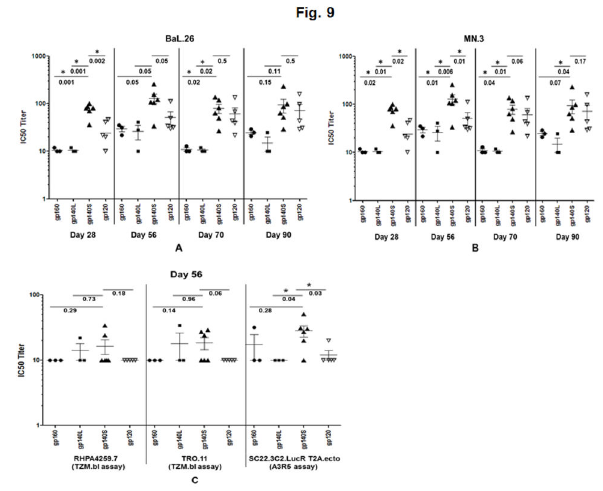
Figure 9. Virus neutralizing antibody activity (50%- inhibitory-concentration [IC ] titers) against homologous 50 HIV-1 clade B tier 1 strains (BaL.26 and MN.3) and heterologous clade B tier 2 strains (RHPA4257.7, TRO.11, and SC22.3C2.LucR. T2A.ecto) in sera from guinea pigs immunized with the indicated rNDVs. (A) Guinea pig sera obtained on days 28, 56, 70 and 90 were tested against BaL.26 pseudovirus by the TZM-bl assay (B) Guinea pig sera obtained on days 28, 56, 70 and 90 were tested against MN.3 pseudovirus by the TZM-bl assay (C) Guinea pig sera obtained on day 56 were tested against RHPA4257.7 and TRO.11 by the TZM-bl assay, and against SC22.3C2.LucR. T2A.ecto by the A3R5 assay. Horizontal bars indicate the geometric mean titer. Pre-immune sera were used to establish baseline- neutralizing activity in each individual guinea pig, and these values were subtracted from the values shown. The neutralizing antibody activity against each virus in sera obtained from guinea pigs immunized with rLaSota virus was <20. Statistical differences between the groups were calculated by unpaired t test (two-tailed) and shown by the numbers underneath the horizontal line. * indicates statistically significant differences ( P <0.05) between